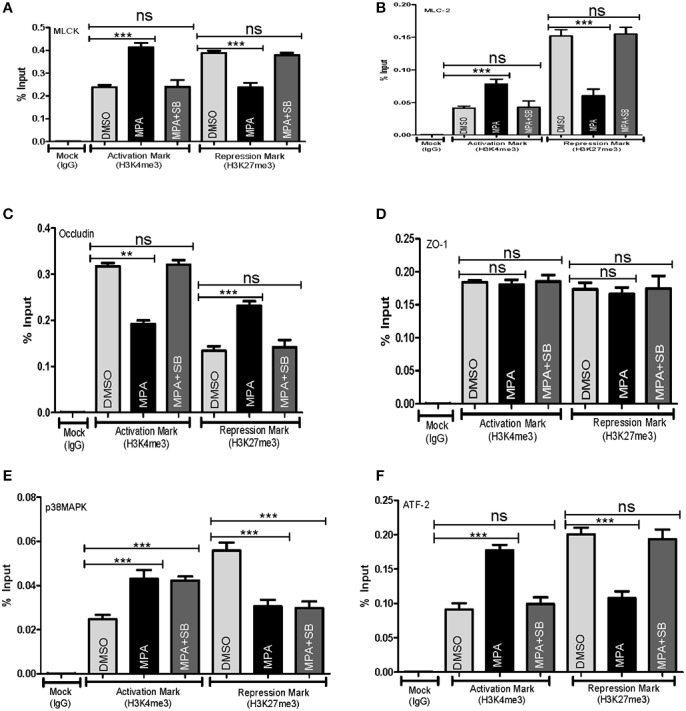
Inhibition of p38MAPK counteracts MPA-mediated epigenetic remodeling. Effect of SB203580 on promoter activity of p38MAPK mediated MLCK/MLC-2 pathways and TJs genes in MPA-treated Caco-2 Cells. (A–F) Bar graphs showing the epigenetic status at the promoter regions of MLCK, MLC-2, occludin, ZO-1, p38MAPK, and ATF-2 genes in either presence or absence of p38MAPK inhibitor. The ChIP-qPCR data was expressed as means ± SEM. Asterisk indicates the significance (**P < 0.01, ***P < 0.001) when compared to control cells. Differences between two groups were analyzed by the two-tailed Student's t-test and of more than two groups by One-way ANOVA with Bonferroni posttest. ns, non-significant.